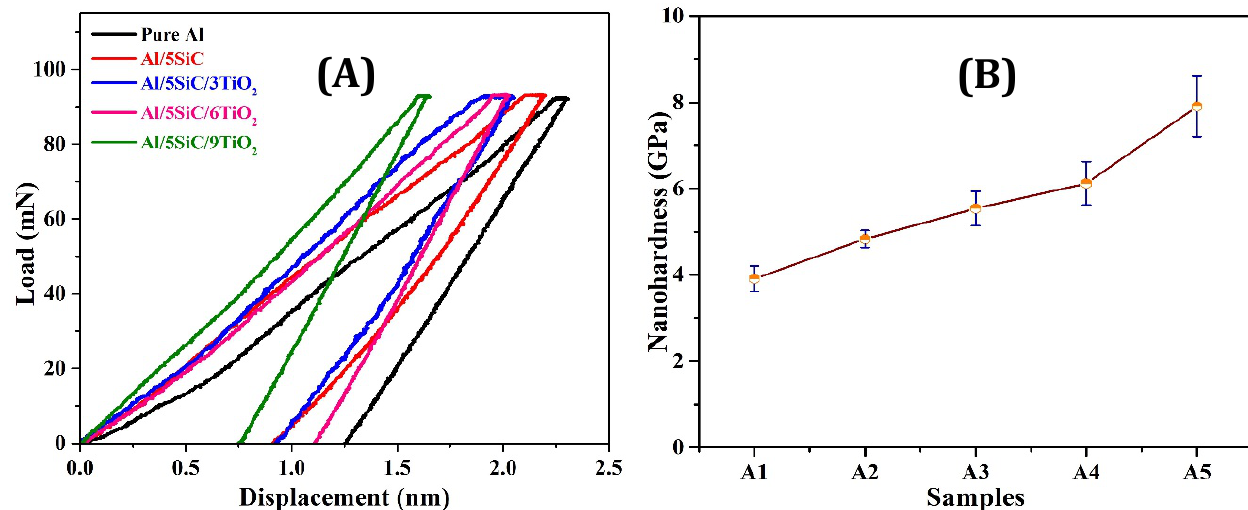
Figure 9. Nanoindentation analysis of Al/SiC/TiO 2 hybrid nanocomposites; ( A ) load/unload-displacement curves and ( B ) nanohardness results.